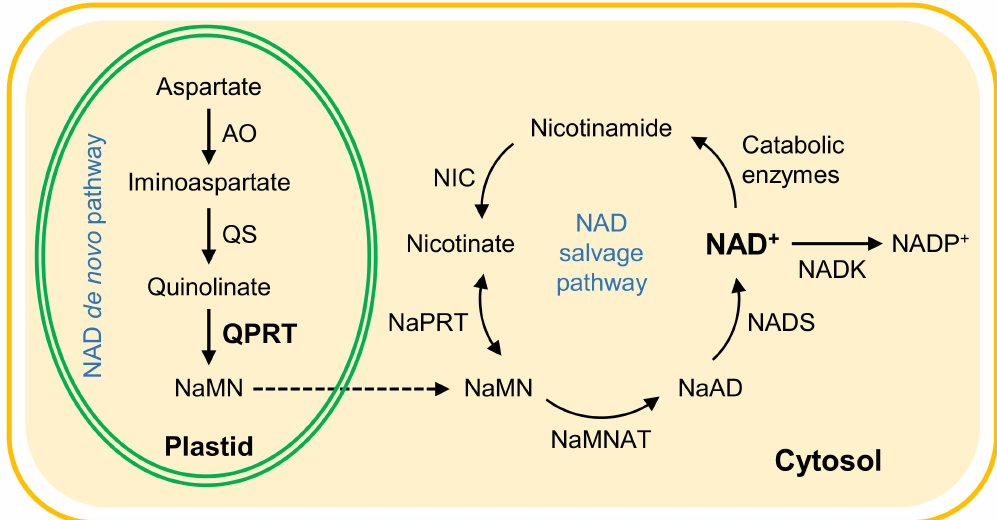
Figure 1. Schematic representation of NAD biosynthesis pathway in plants. The de novo biosynthesis of NAD starts from aspartate in the plastid. Abbreviations: AO, aspartate oxidase; NaAD, nicotinate adenine dinucleotide; NADK, NAD kinase; NADS, NAD synthetase; NaMN(AT), nicotinate mononucleotide (adenylyltransferase); NaPRT, nicotinate phosphoribosyltransferase; NIC, nicotinamidase; QPRT, quinolinate phosphoribosyltransferase; QS, quinolinate